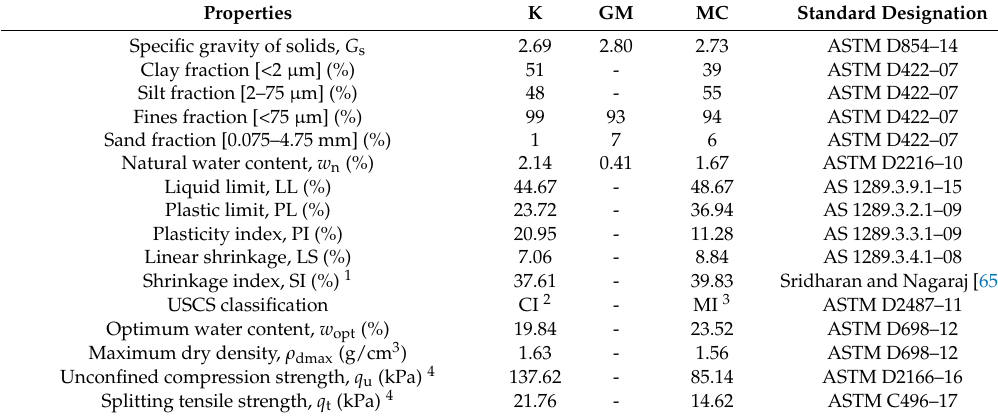
Table 1. Physical and mechanical properties of K, GM and